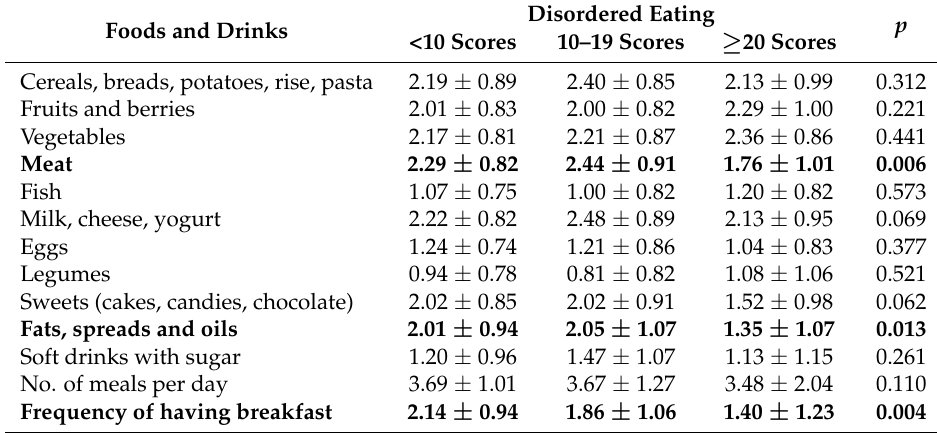
Table 8. Comparison of nutrition habits of adolescent girls in groups of disordered eating (m ± SD) 1 , ( n =